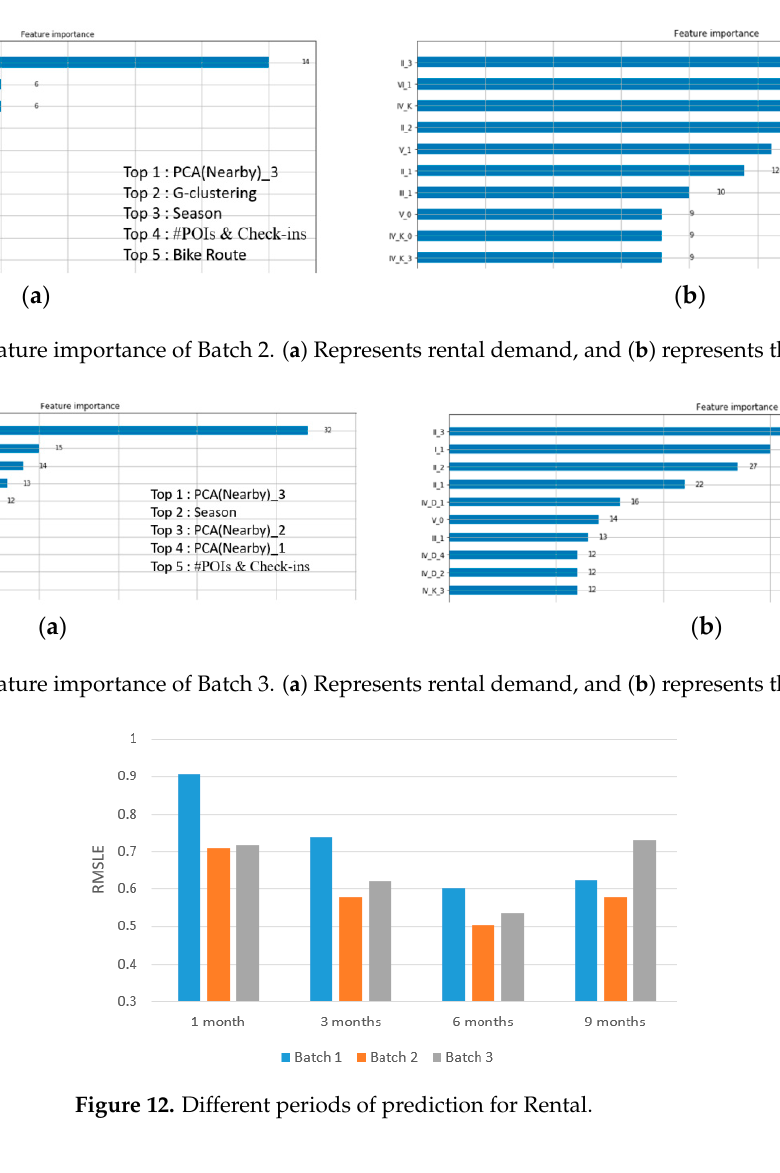
Figure 9. Feature importance of Batch 1. ( a ) Represents rental demand, and ( b ) represents the drop-off one.